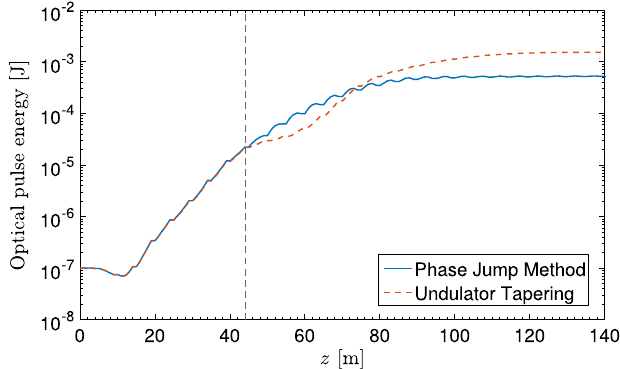
FIG. 10. Result of time-dependent simulation. The optical pulse energy is plotted as a function of the distance z along the undulator line for the optimal phase jumps (blue) and the optimal taper (red). The dashed vertical line indicates the common starting point for the phase jump method and the taper. The vertical axis is on a logarithmic